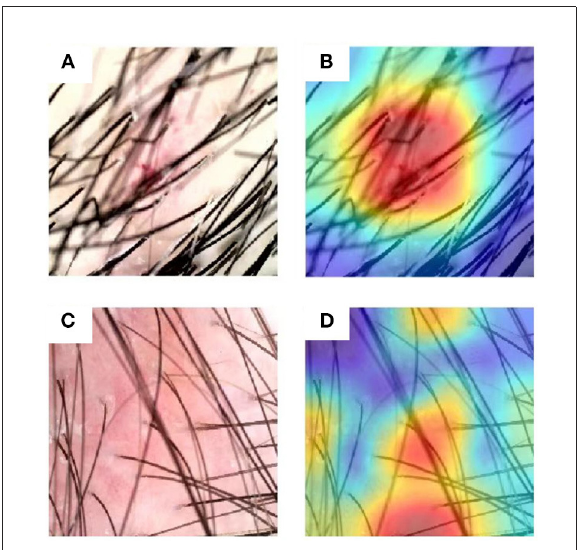
FIGURE9 Exemplary images that were misdiagnosed and corresponding attention distributions of the DL model. (A,B) An example image of seborrheic dermatitis and the associated attention distribution from the DL model, respectively. (C,D) An example image of psoriasis and the associated attention distribution from the DL model